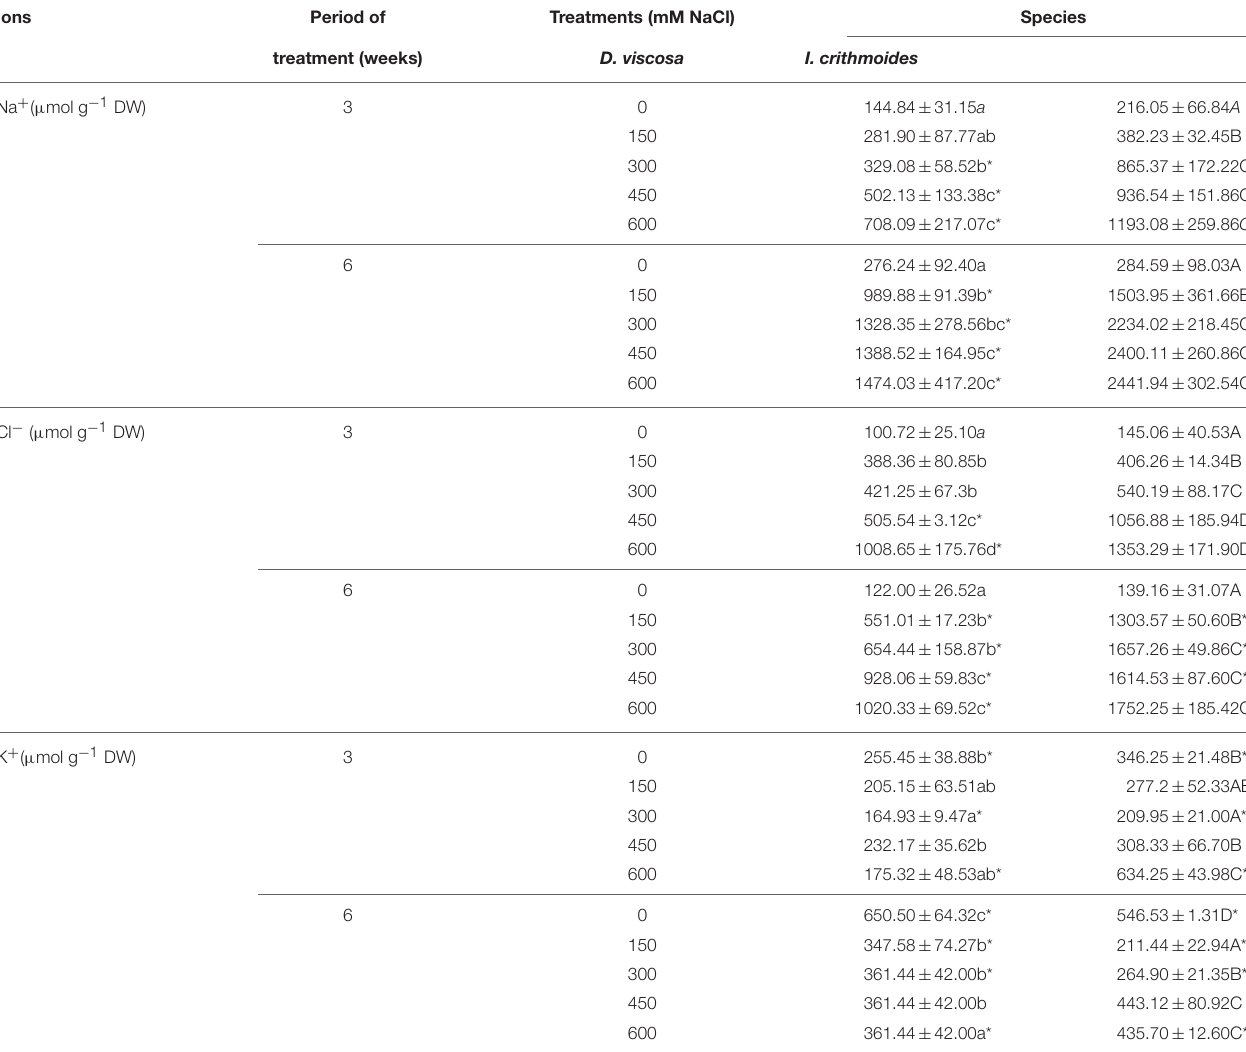
TABLE 3 | Monovalent ion contents in leaves of salt-treated D. viscosa and I. crithmoides plants.